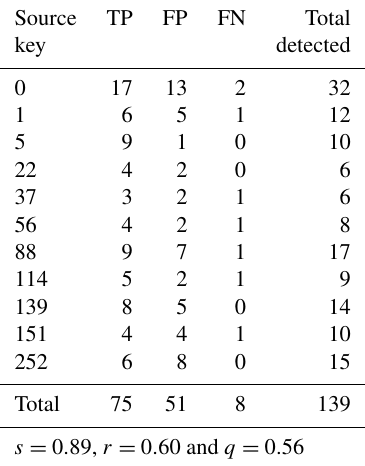
Table 2. Accuracy metrics for calibration site I (Smugglers catch- ment, California, USA).